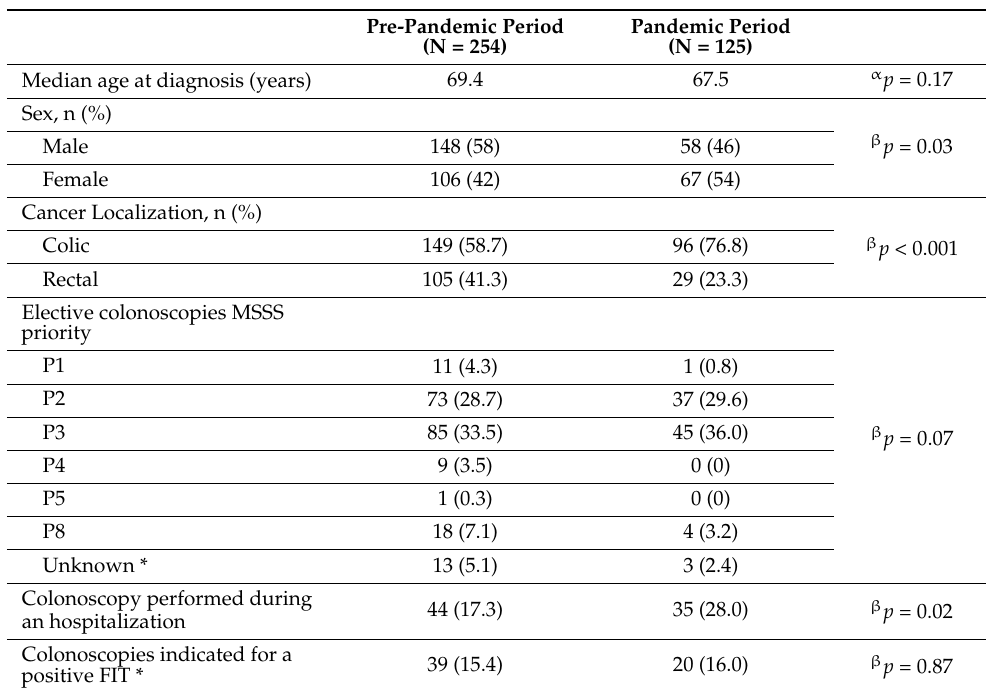
Table 1. Clinical characteristics of patients diagnosed with CRC during the pre-pandemic and the pandemic